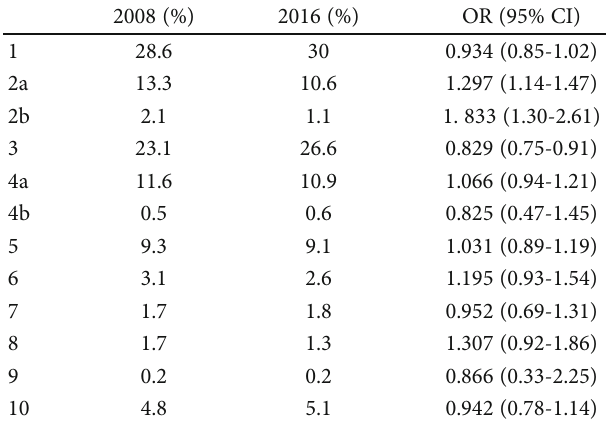
Table 7: Robson ’ s 10-Group Classi fi cation of a selected group of Flemish women giving birth in 2008 and 2016: relative size of each group in total birth (%).